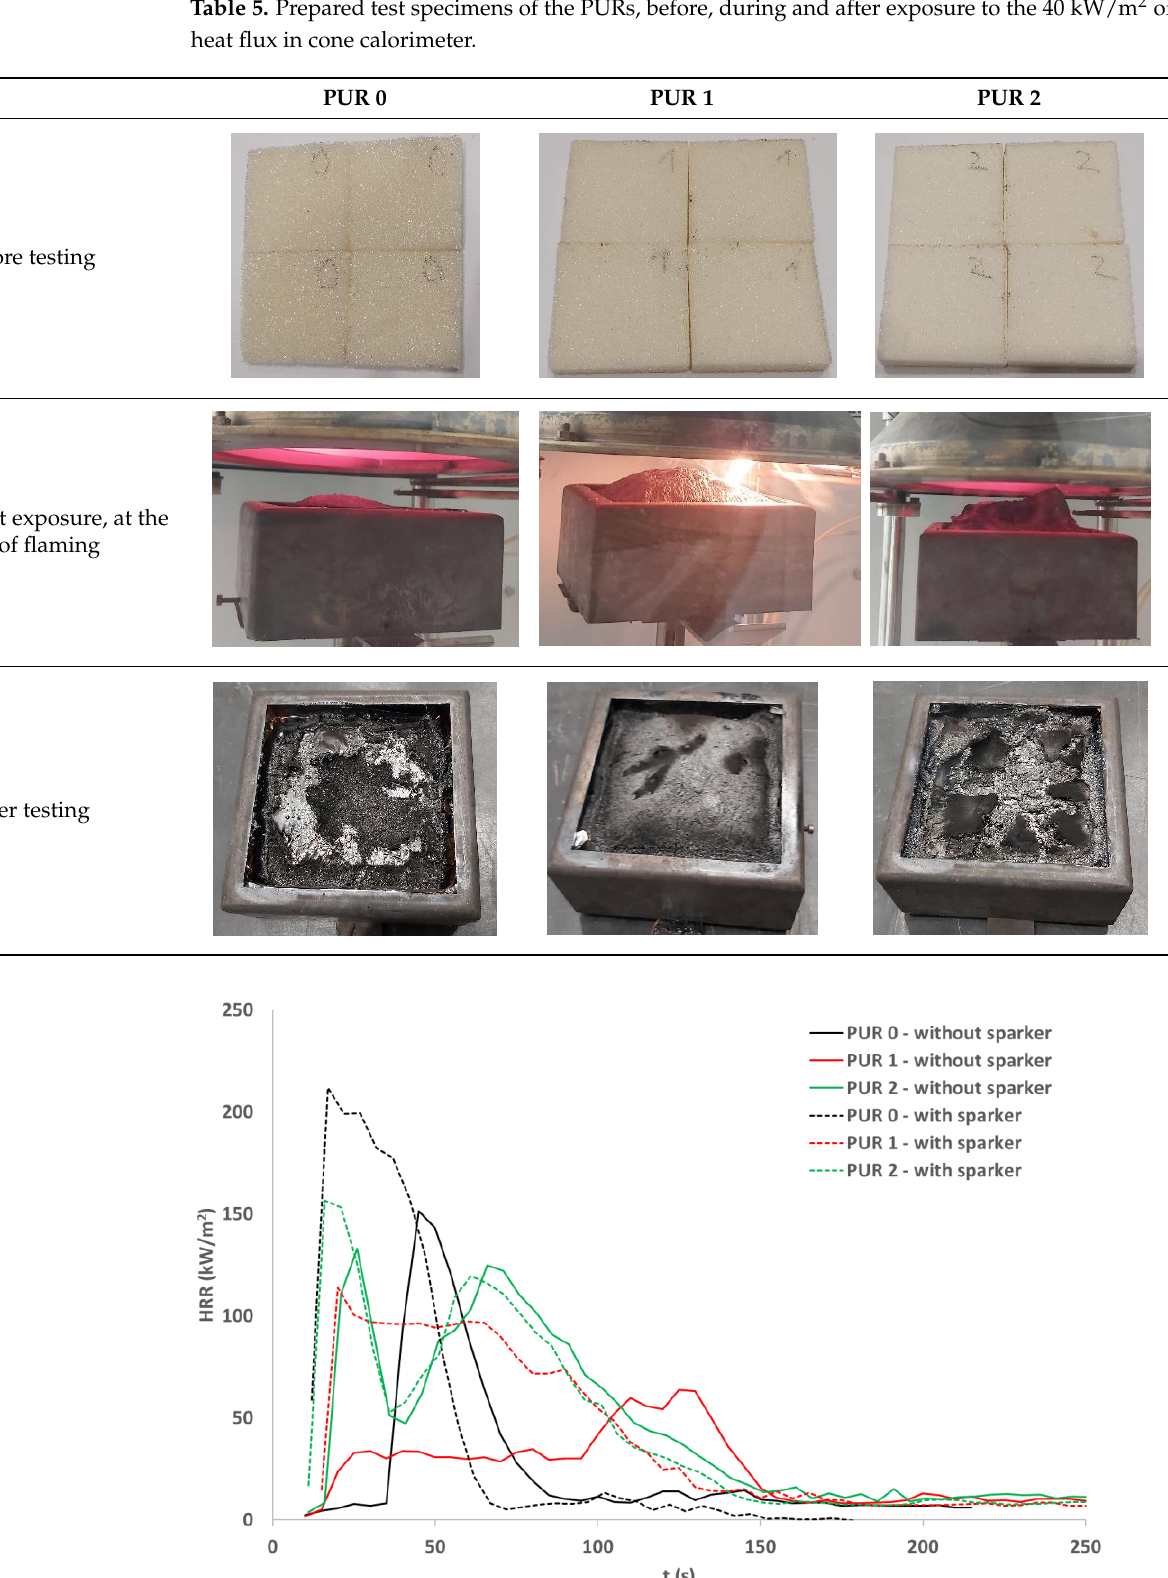
Table 5. Prepared test specimens of the PURs, before, during and after exposure to the 40 kW/m 2 of heat flux in cone calorimeter.